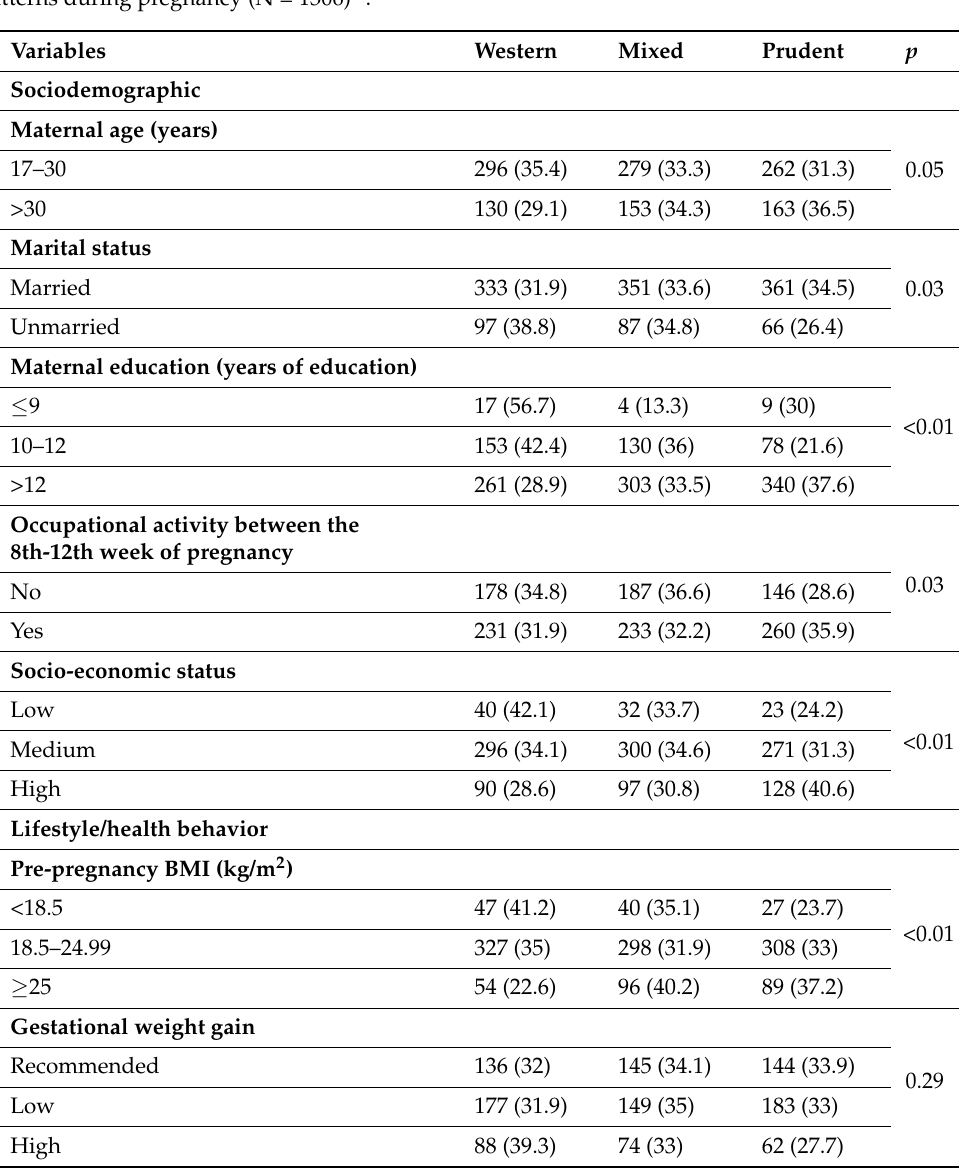
Table 2. Sociodemographic, lifestyle, environmental, and pregnancy-related factors and dietary patterns during pregnancy (N = 1306)